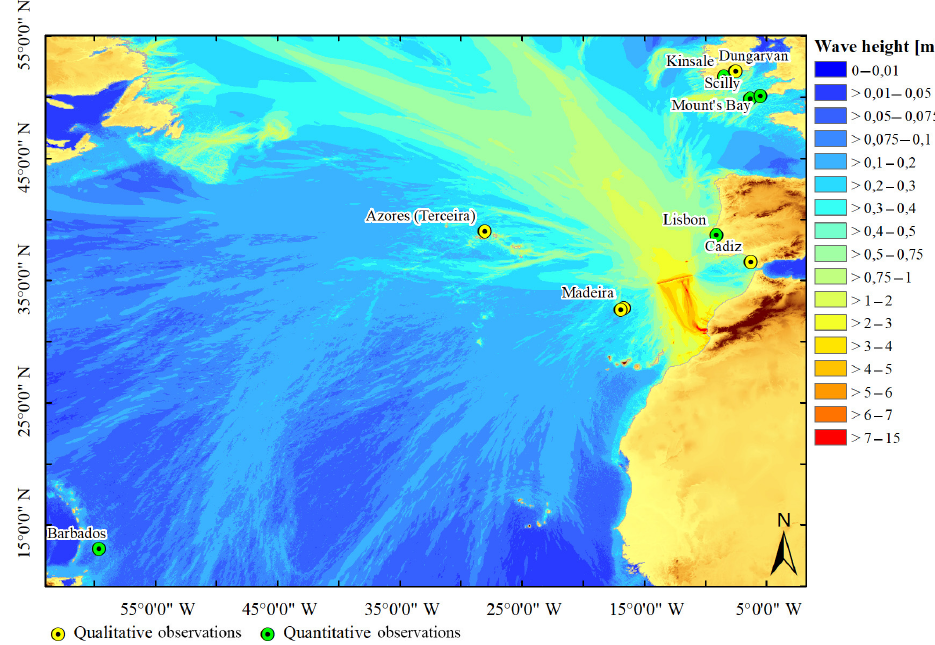
Figure 6. Maximum wave height distribution (colour scale in m) in the Atlantic basin produced by the source of hypothesis